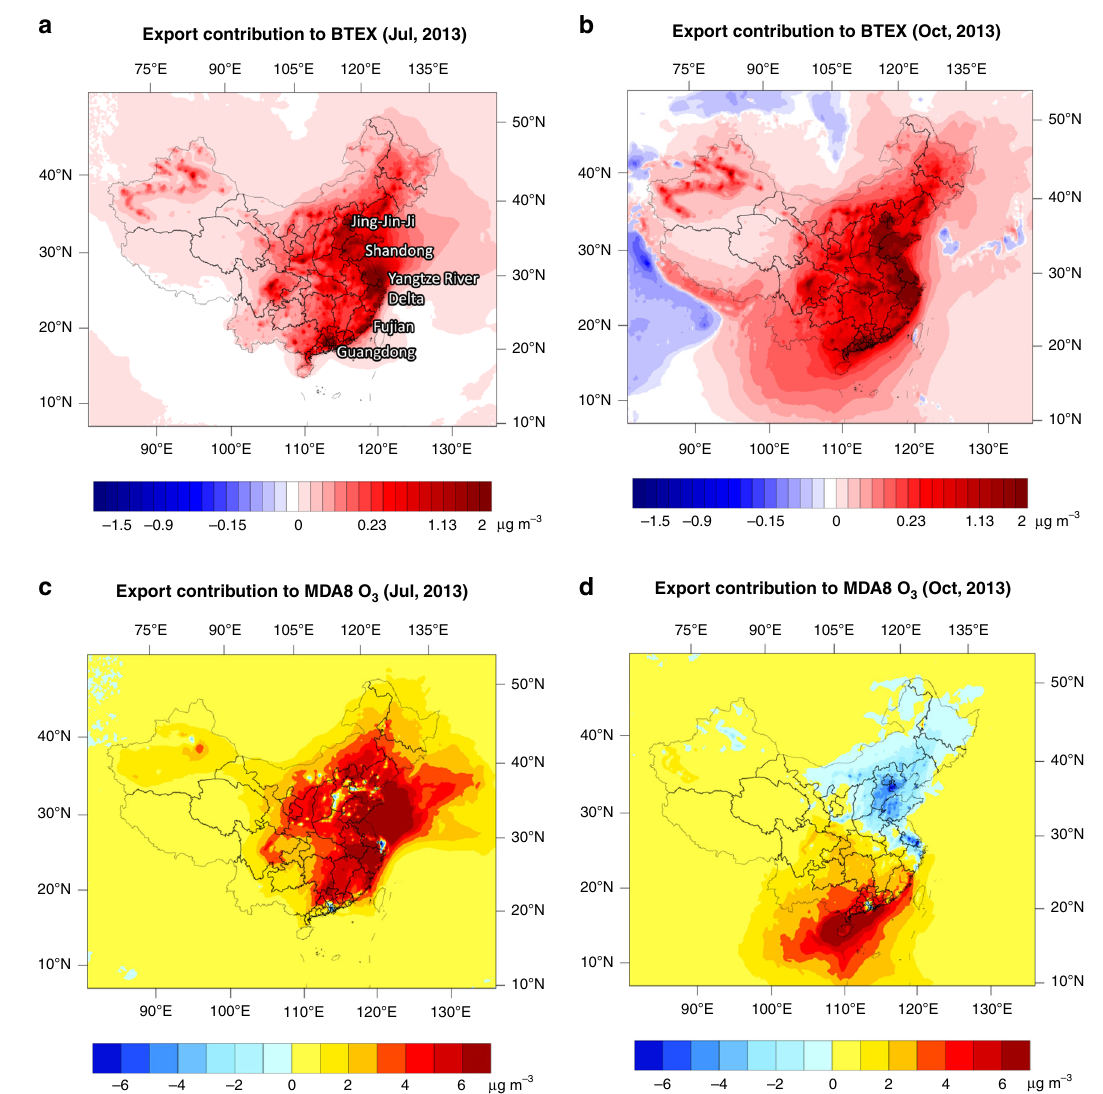
Fig. 3 Export contributions to ambient BTEX and O 3 concentrations in China. a , b Export increased the BTEX concentrations all year round in China, especially in the North China Plain and coastal areas (>0.5 µ g m − 3 ). c Export elevated the peak O 3 level in July by 2 – 6 µ g m − 3 , varying from provinces. d Effects from export were mixed in October. While export emissions still contributed positively to the O 3 formation in south China, it inhibited peak O 3 by 1 – 3 µ g m − 3 in the vast areas north to the Yangtze River Delta, especially the Jing-Jin-Ji area (3 – 5 µ g m − 3 ). Source data are provided as a Source Data fi